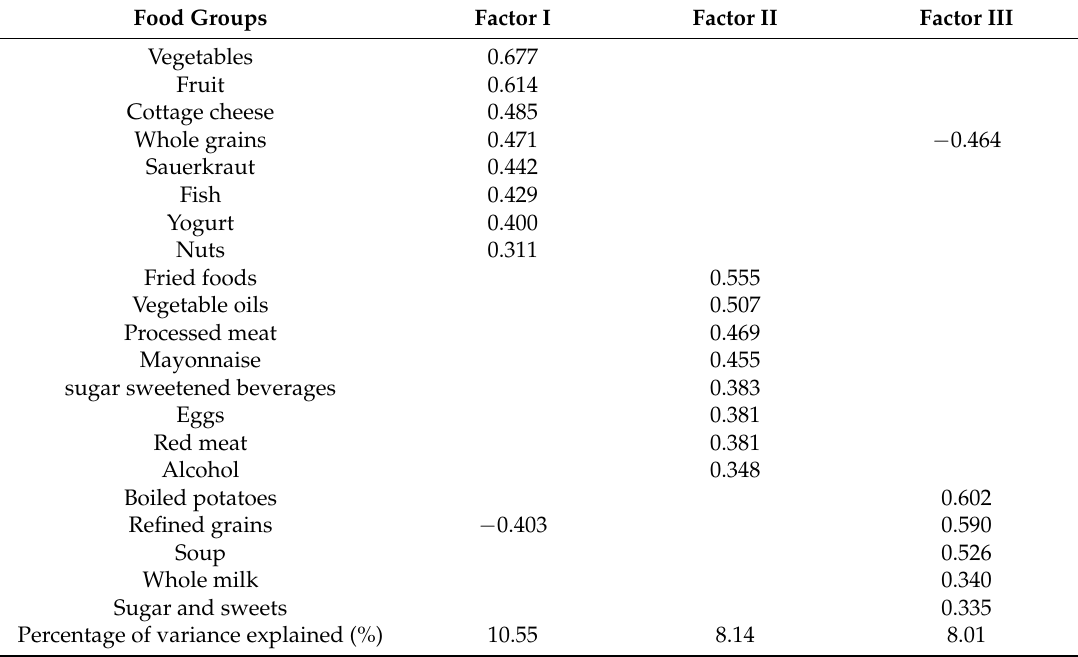
Table 1. Factor-loading matrix for major dietary patterns